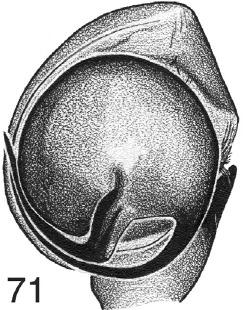
Figure 71. Habronattus cf. carolinensis , from Lake Temagami, Ontario, male left palp, ventral view.